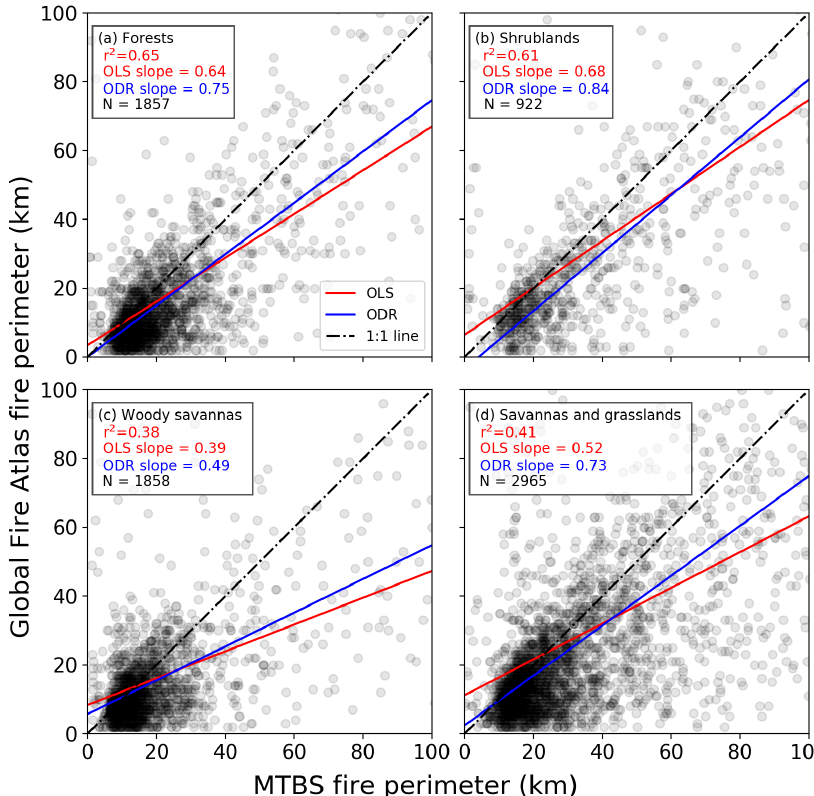
Figure 5. Comparison of fire perimeter estimates based on the Global Fire Atlas and MTBS for the continental US (2003–2015). (a) Forests, (b) shrublands, (c) woody savannas, and (d) savannas and grasslands. Red lines indicate the slope between both datasets based on ordinary least squares (OLS) with corresponding r 2 values, while blue lines are based on orthogonal distance regression (ODR). For the scatterplots, darker gray or black indicates a greater density of